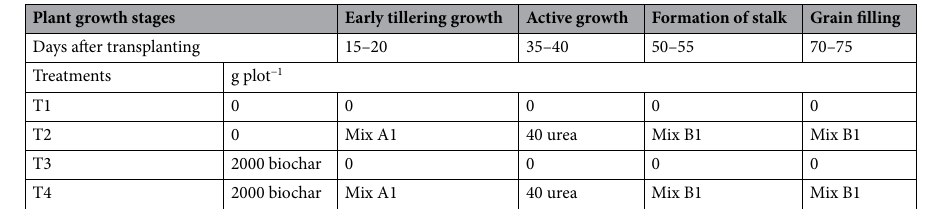
Table 2. Chicken litter biochar rates and fertilization schedule for field study. Mix A1 = (55 g Urea + 80 g ERP + 24 g MOP). Mix B1 = (18 g Urea + 30 g ERP + 20 g MOP + 1.4 MgO). ERP = Egyptian rock phosphate. MOP = Muriate of potash.